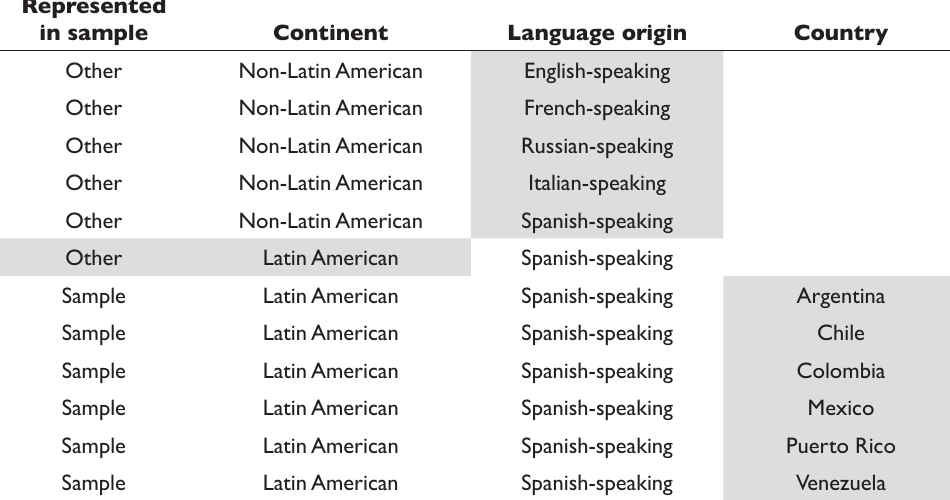
Table 2: Coding system for origin of